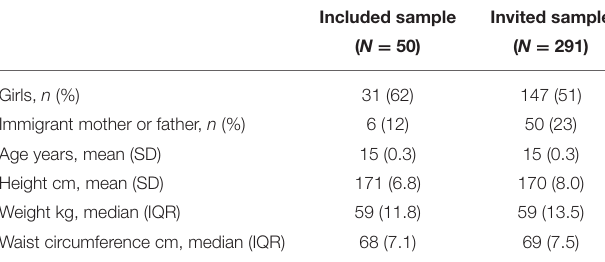
TABLE 1 | Characteristics of the sample and the main